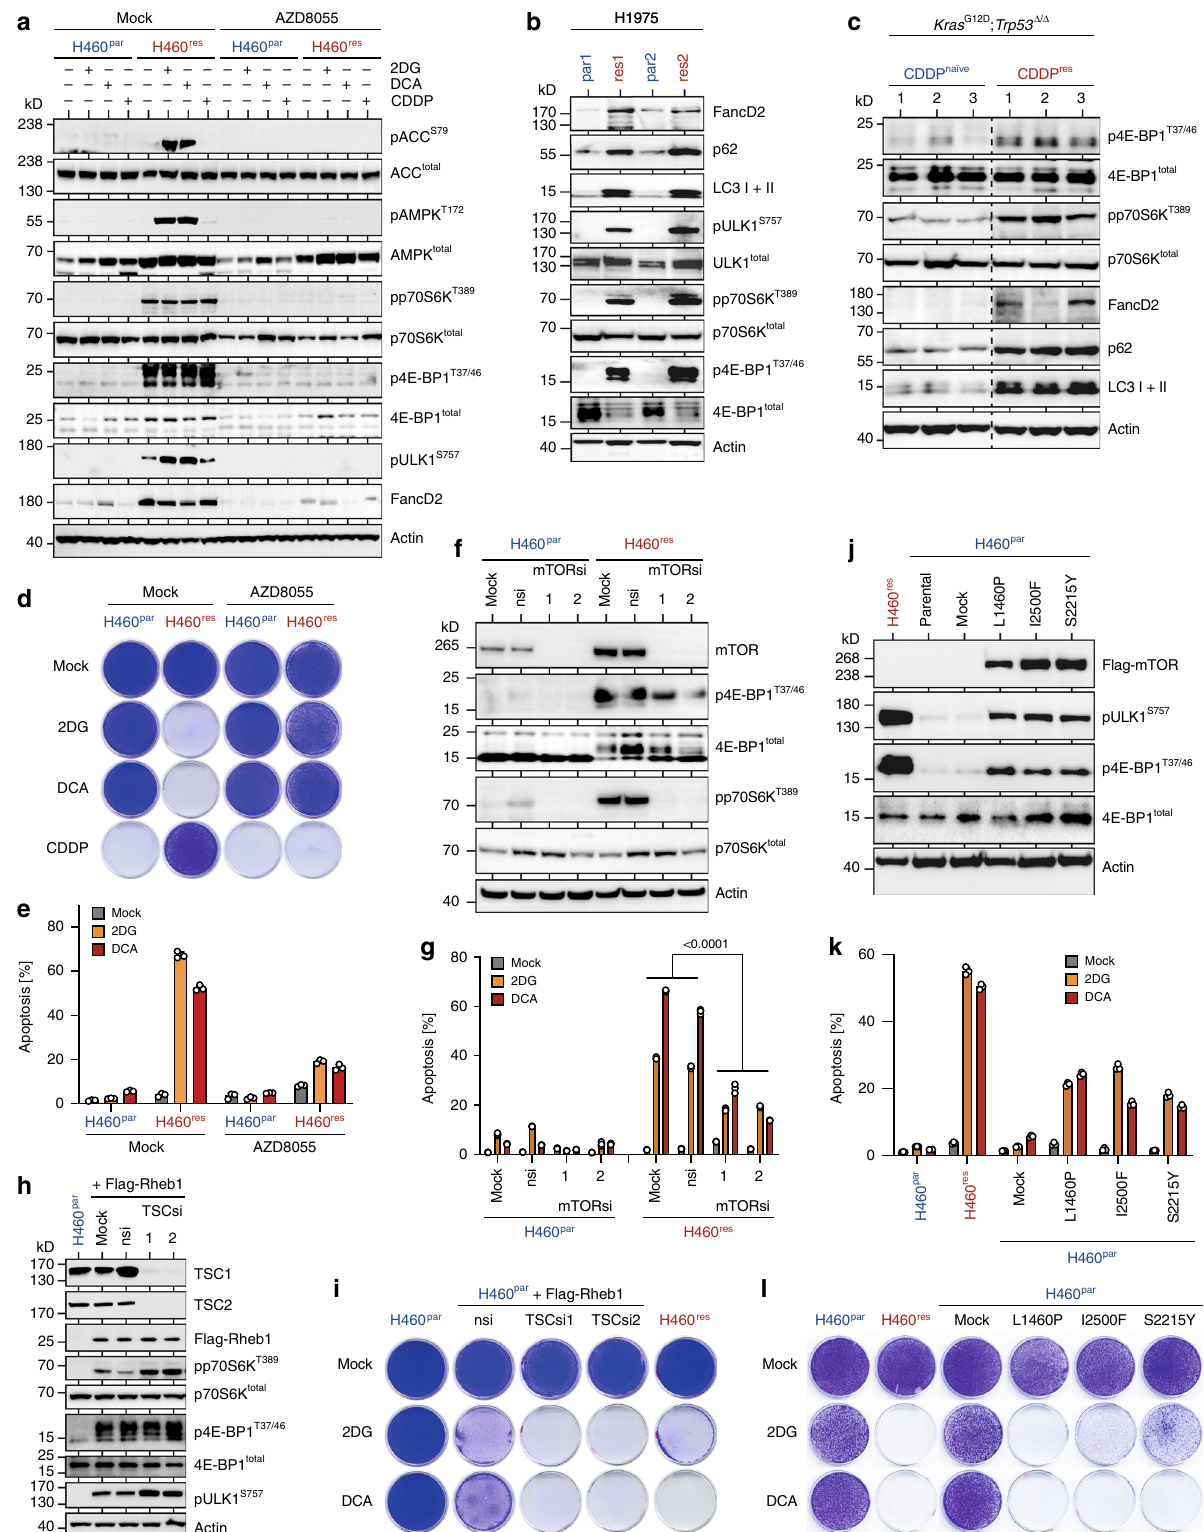
FIP200, two genes considered speci fi c for autophagy, whereas knockdown of RUBCN, involved in LAP but not classic autop- hagy, showed no effect (Supplementary Fig. 3) 43,44 . Of note, autophagy de fi ciency by knockout of ATG7, ATG14, or FIP200 did not alter CDDP sensitivity (Supplementary Fig. 3).